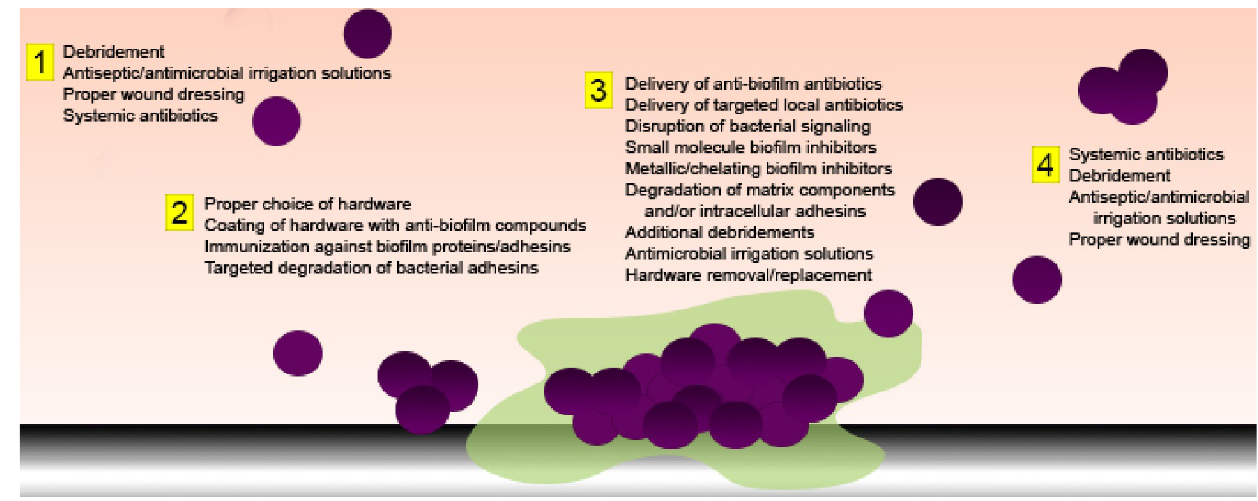
Figure 2. Anti-biofilm strategies aimed at various stages of bacterial growth and attachment. Both pharmacological and mechanical strategies can be employed in attempts to: 1) remove or eradicate planktonic bacteria, 2) prevent primary attachment, 3) degrade matrix components and/or facilitate active dispersal of biofilm bacteria, or 4) remove or eradicate dispersed or sloughed bacteria or biofilm